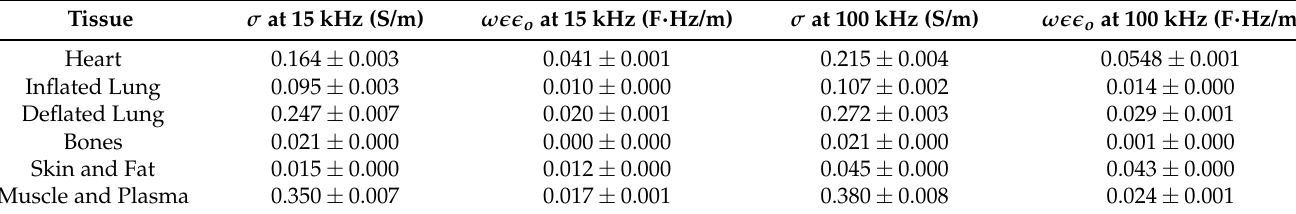
Table 1. Assigned conductivity and permittivity values to the thoracic models’ tissues for f = 15 kHz and f = 100 kHz. The admittance is estimated as γ = σ + j ω(cid:101)(cid:101) o . For the skin and fat case, the average values of wet skin and breast fat admittances (see Figure 3) were used.